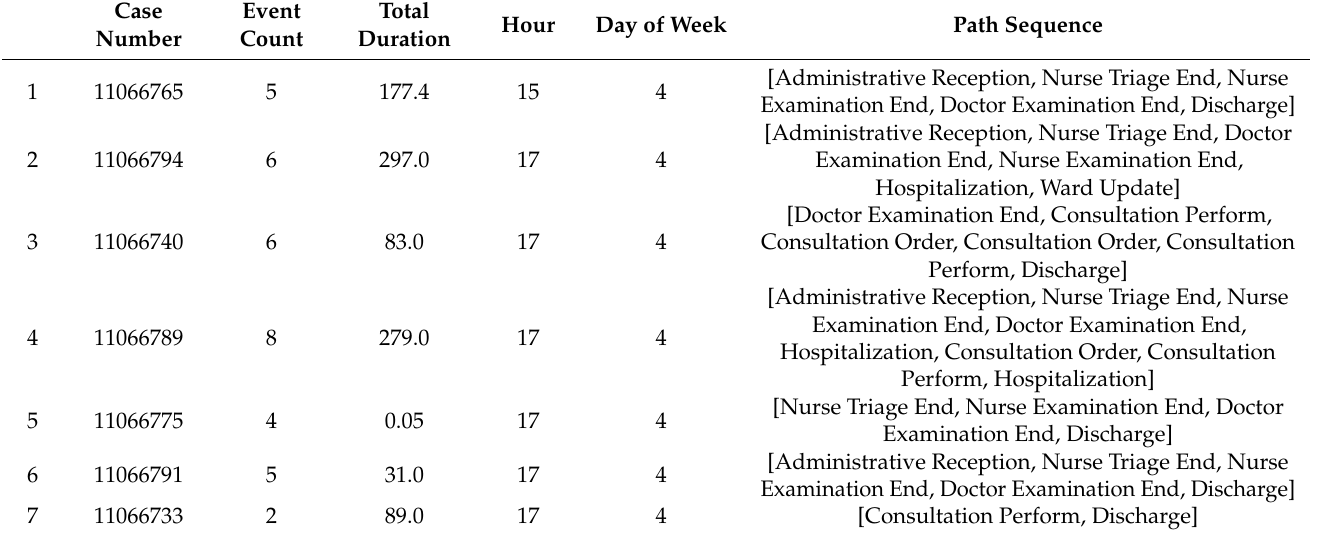
Table 2. The number of events, the path sequence, the total duration of the journey, and the day and the hour patient journey started through their ED experience.